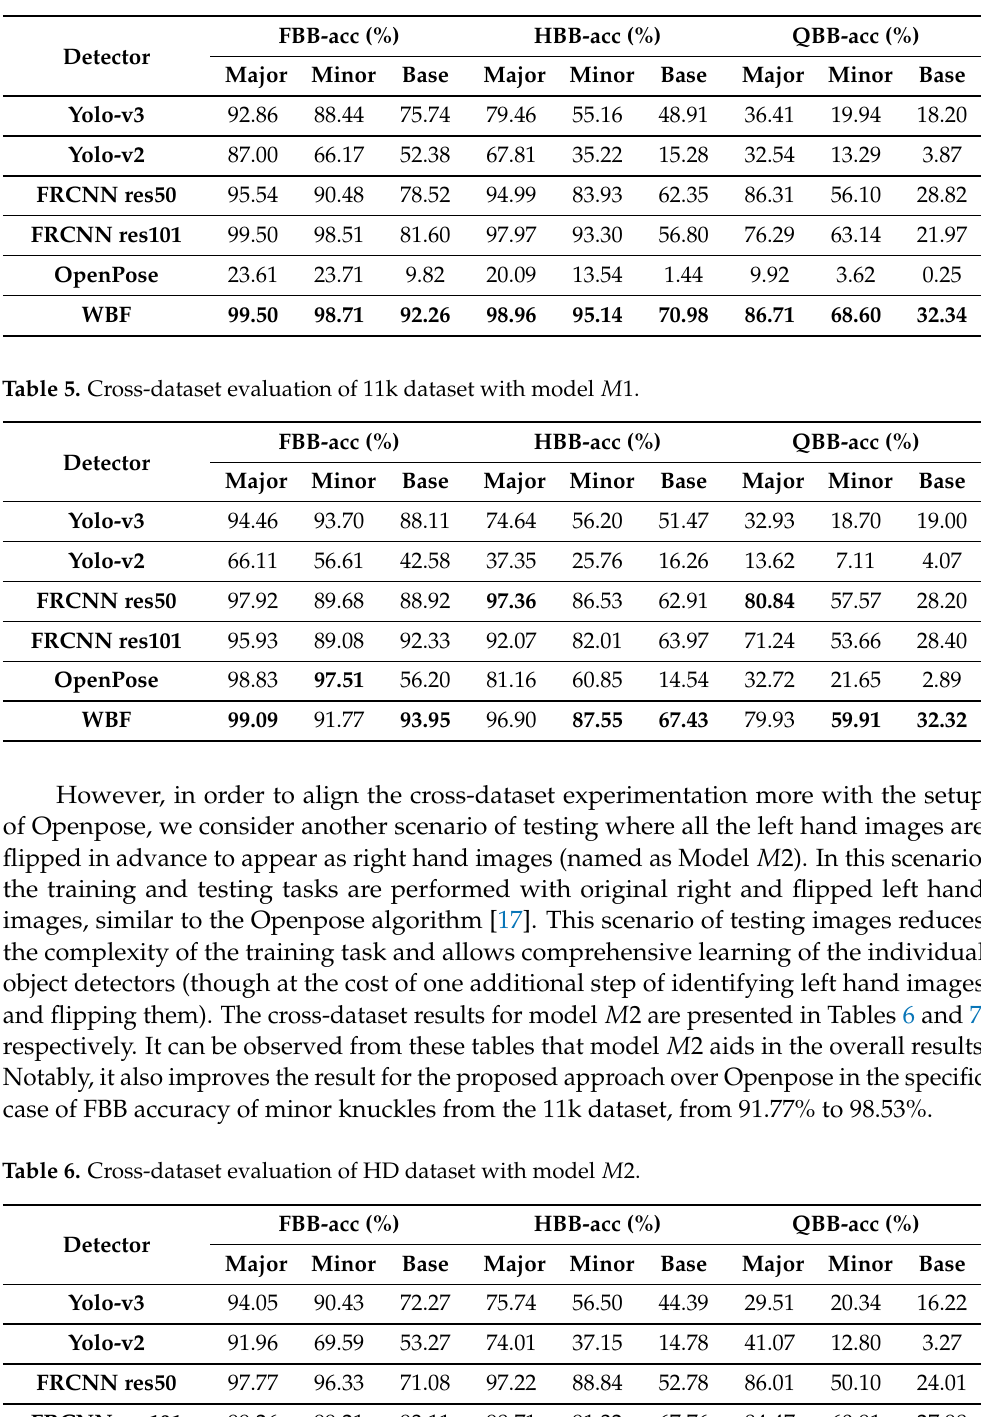
Table 4. Cross-dataset evaluation of HD dataset with model M 1.